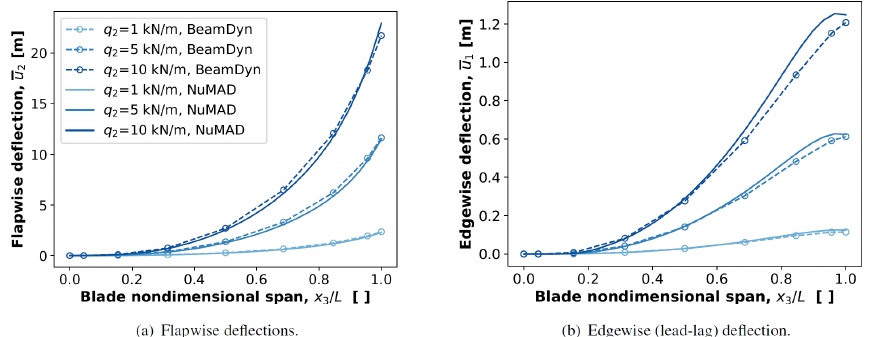
Figure 7. Flapwise and edgewise static deflection comparison between NuMAD and BeamDyn during a design iteration for BAR-UAG.